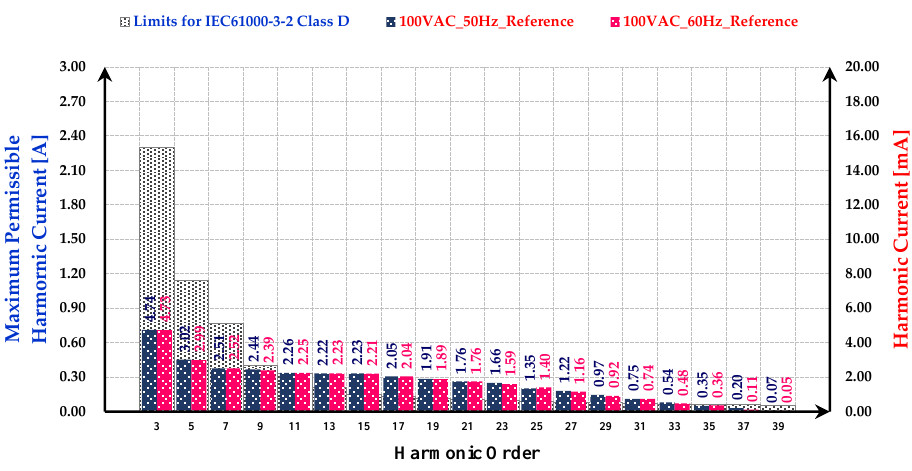
Figure 12. Harmonic current at 100 VAC 50/60 Hz.